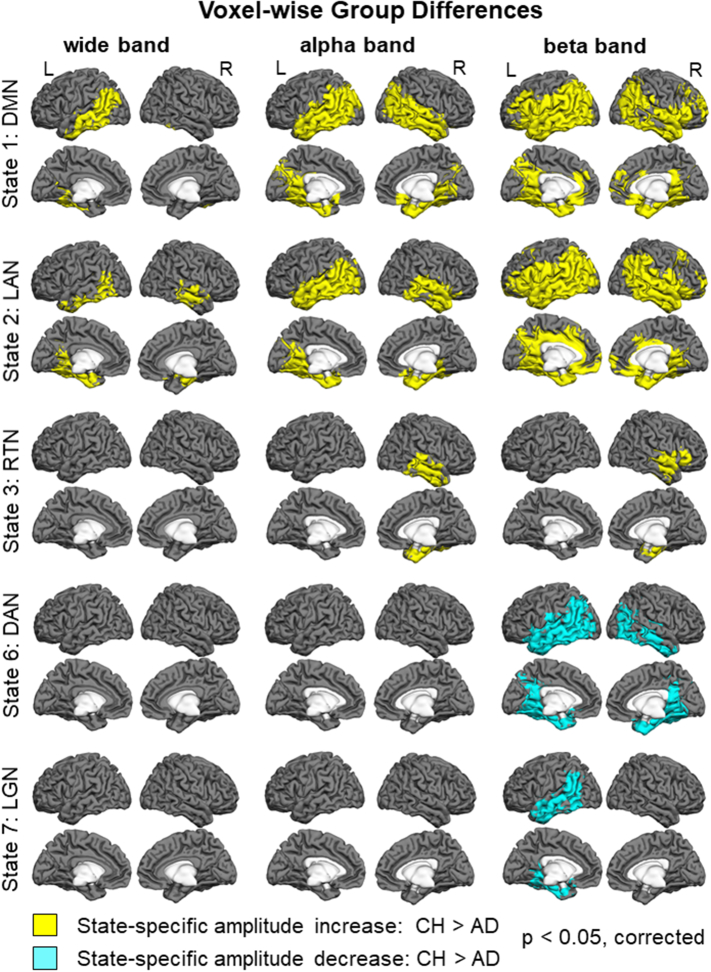
Maps of group differences in the voxel-wise state-specific activity changes in the wide band (4–30 Hz) in the left panel, in the alpha band (8–12 Hz) in the central panel, and in the beta band (15–30 Hz) in the right panel. Brain voxels where the state-specific enhancement in the oscillatory amplitude was less prominent in the AD relative to CH group are shown in yellow color. Brain voxels where the state-specific attenuation in the oscillatory amplitude was less prominent in the AD relative to CH group are shown in blue color. Abbreviations are the same as in Fig. 2.